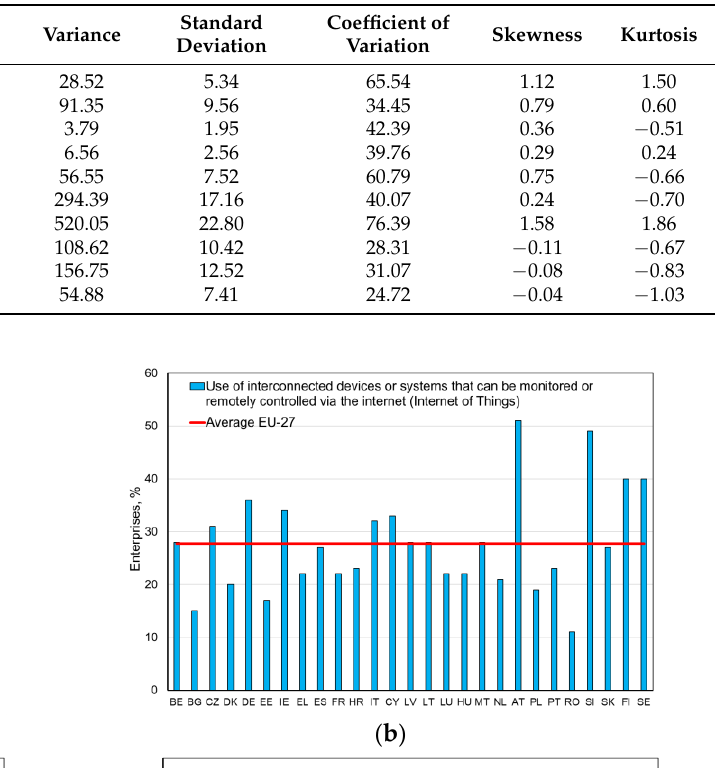
Table 3. Basic static parameters of studied variables.